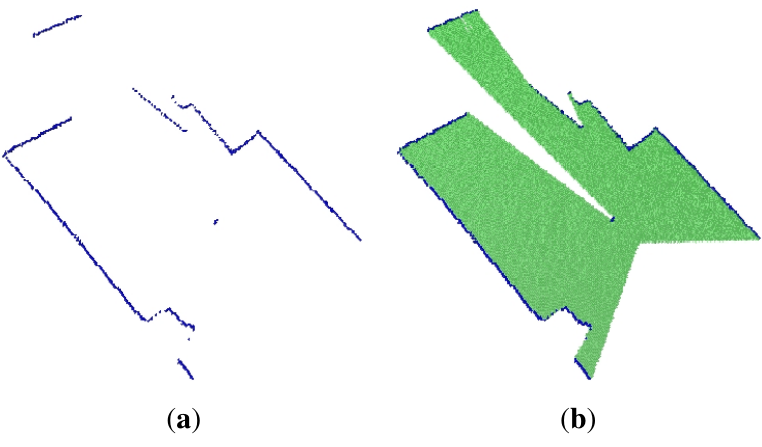
Figure 12. Improvement of the minimum range detection of the Kinect